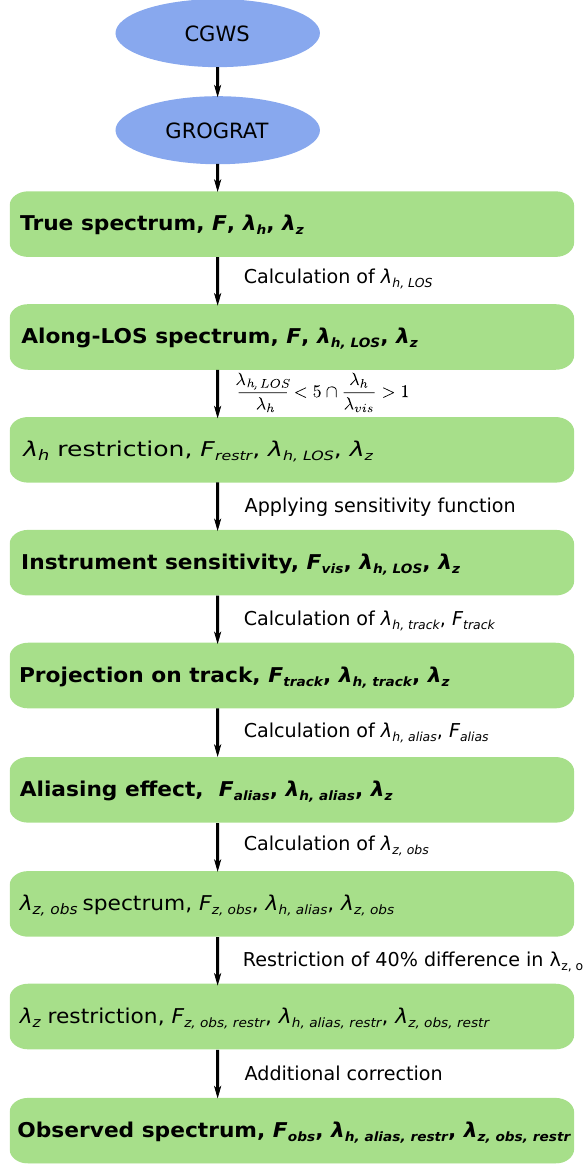
Figure 11. Overview of all steps the observational filter. The steps with significant changes are marked by bold